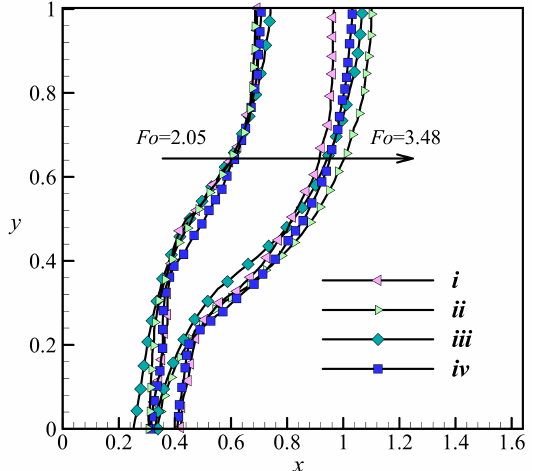
Figure 7. Comparison of the present computated melting lines to the review of [53]. i: the results of Kashani et al. [55], ii: the results of Gau and Viskanta (experiment); iii: the results of Brent et al.; and iv: the present study with Fo = 3.48 and 2.05, when the Prandtl number Pr = 50 and the Rayleigh number Ra = 1.25 × 10 5 .